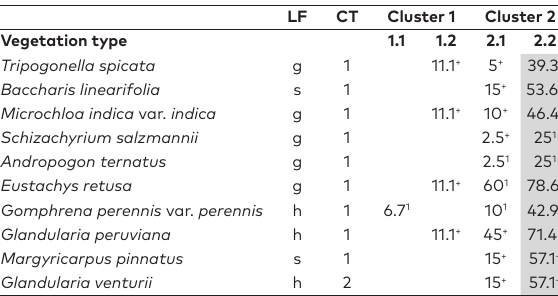
Vegetation classification The vegetation matrix was classified by the ISOPAM anal- ysis into two main clusters (C1 and C2) and each cluster was further partitioned into two vegetation types (Table 1). Species constancy and average cover data are reported in synoptic Table 1 and also in the extended Suppl. material 1: Table S1.1. Cluster 1 comprised relevés collected mainly in the plains located to the east and north of the study area (Es- pinal and the Lowland Chaco, respectively), while Cluster 2 included relevés distributed predominantly, but not exclu- sively, in low mountain ranges and valley bottoms located to the north and west of the area (Lowland Chaco and the Mountain Chaco, respectively). Although the sample-size- based rarefaction showed that the curves of the four vege- tation types had not yet reached the asymptote (Figure 3A), the observed species richness reached a high percentage of the species estimated using the non-parametric estimators (Table 2). The coverage-based rarefaction curves suggested that the four vegetation types identified were well repre- sented since the sample coverage percentage showed values equal or higher than 0.85 in all types (Figure 3B, C; Table 2). Table 2. Species observed (S ) and non-parametric es- obs timators of species richness plus standard error for in- cidence data for each vegetation type. Vegetation